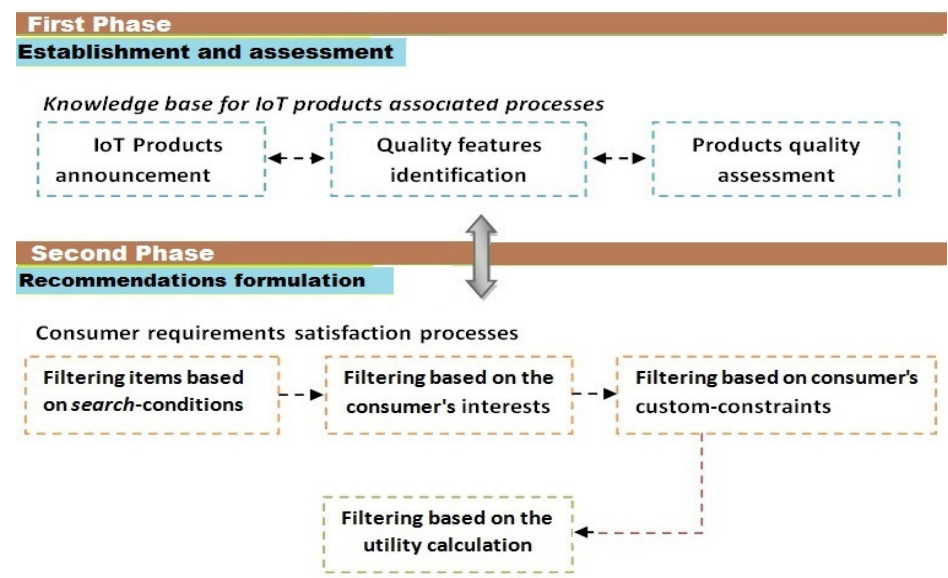
Figure 1. A methodology for assessing and recommending IoT products.